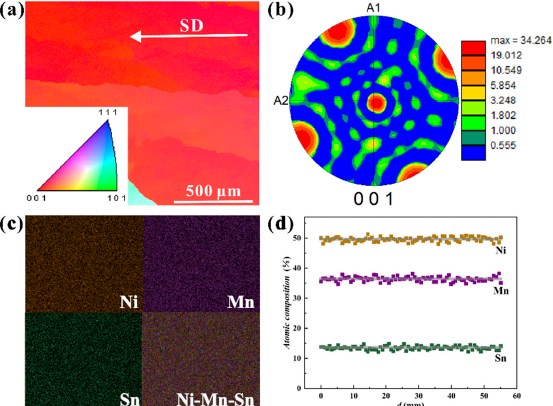
Figure 2. Scanning electron microscopy on the Ni–Mn–Sn crystal. ( a ) EBSD orientation mapping of the longitudinal section expressed in inverse pole figure (IPF) mode. ( b ) (001) pole figure (PF) along the SD calculated from the orientation mapping. ( c ) EDS elemental maps. ( d ) Compositional distribution along the crystal growth